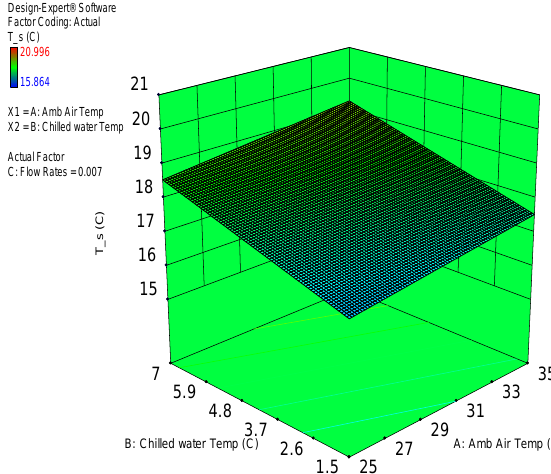
Figure 13: 3-D plots of chilled water and ambient air effects on cooled